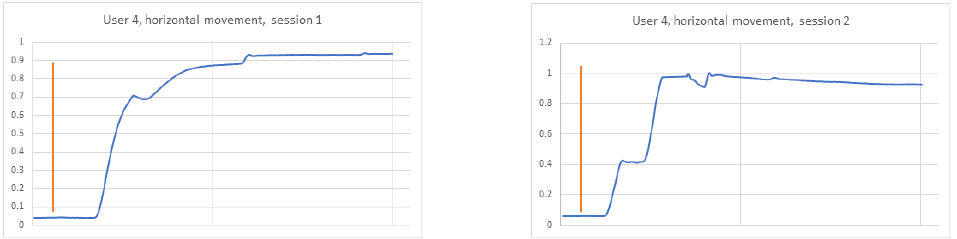
Figure 9. Horizontal signal–user 4 session 1 on the left , session 2 on the right .